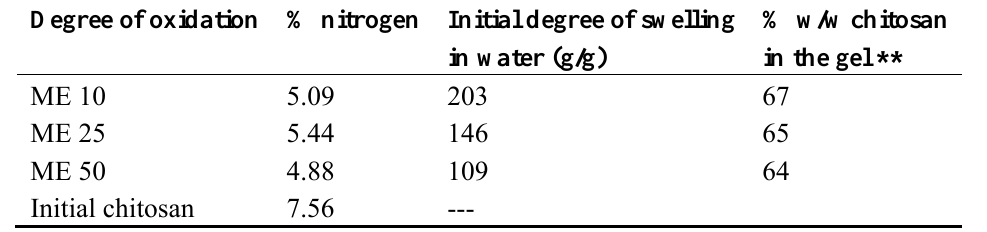
Table 2. Characterization of chitosan crosslinked with oxidized methylcelluloses